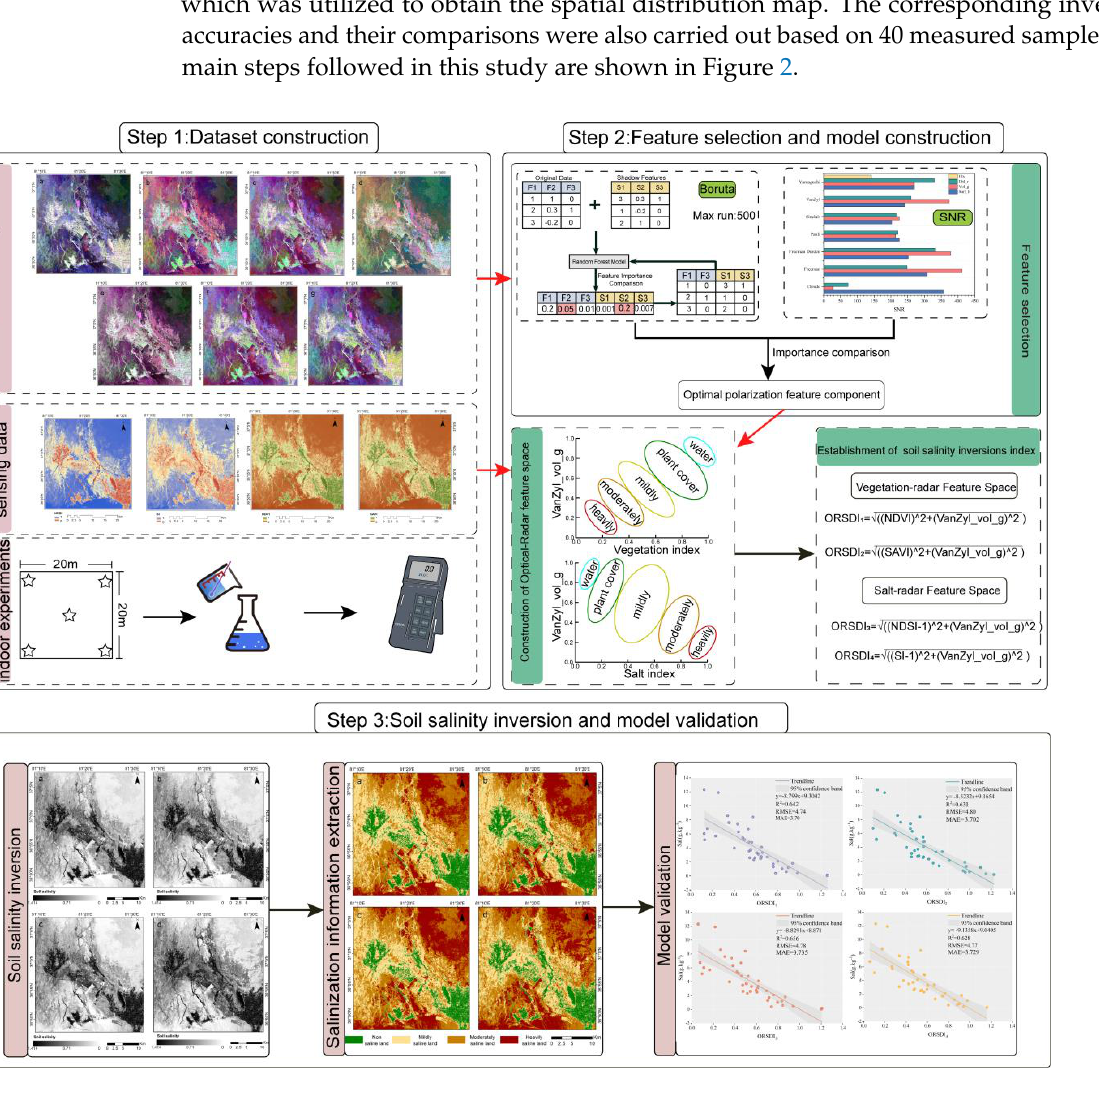
Figure 2. The overall workflow of the